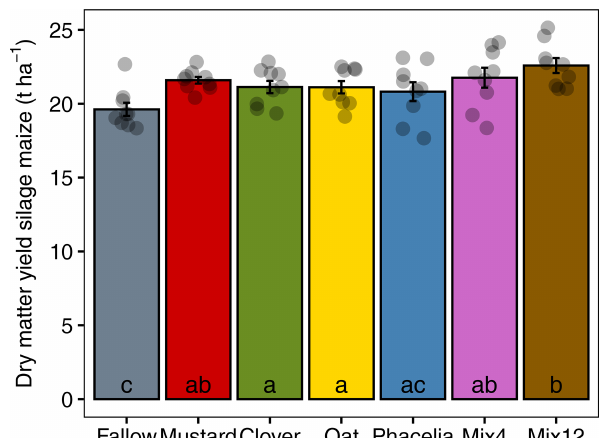
Figure 6. Silage maize yield following different CC treatments from Asendorf field site in 2019. Small letters denote significant differences between CC